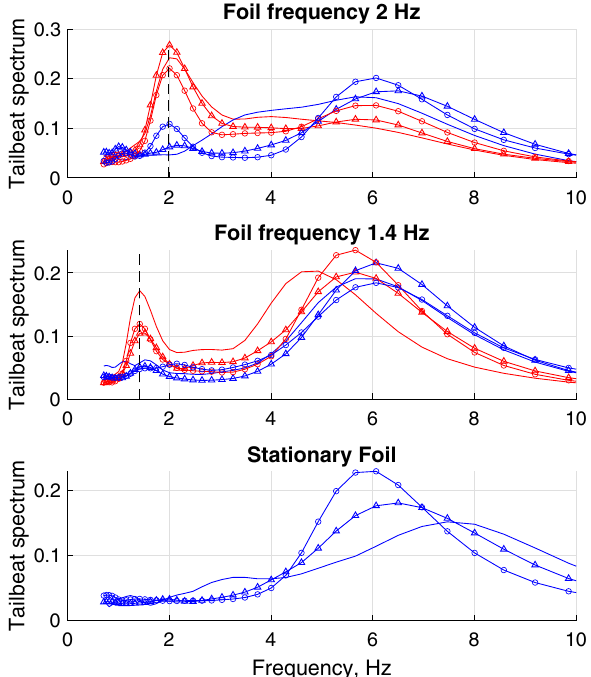
Figure 3. Frequency spectra of the curvature of fish body in different swimming regimes. Blue—regular swimming outside the wake, red—altered gait in the hydrofoil wake. Each marker corresponds to an individual fish. The vertical dashed line indicates foil oscillation frequencies. A clear peak at the hydrofoil oscillation frequency is evident in the altered gait cases, corresponding to the fish tuning their body shapes to the vortices.